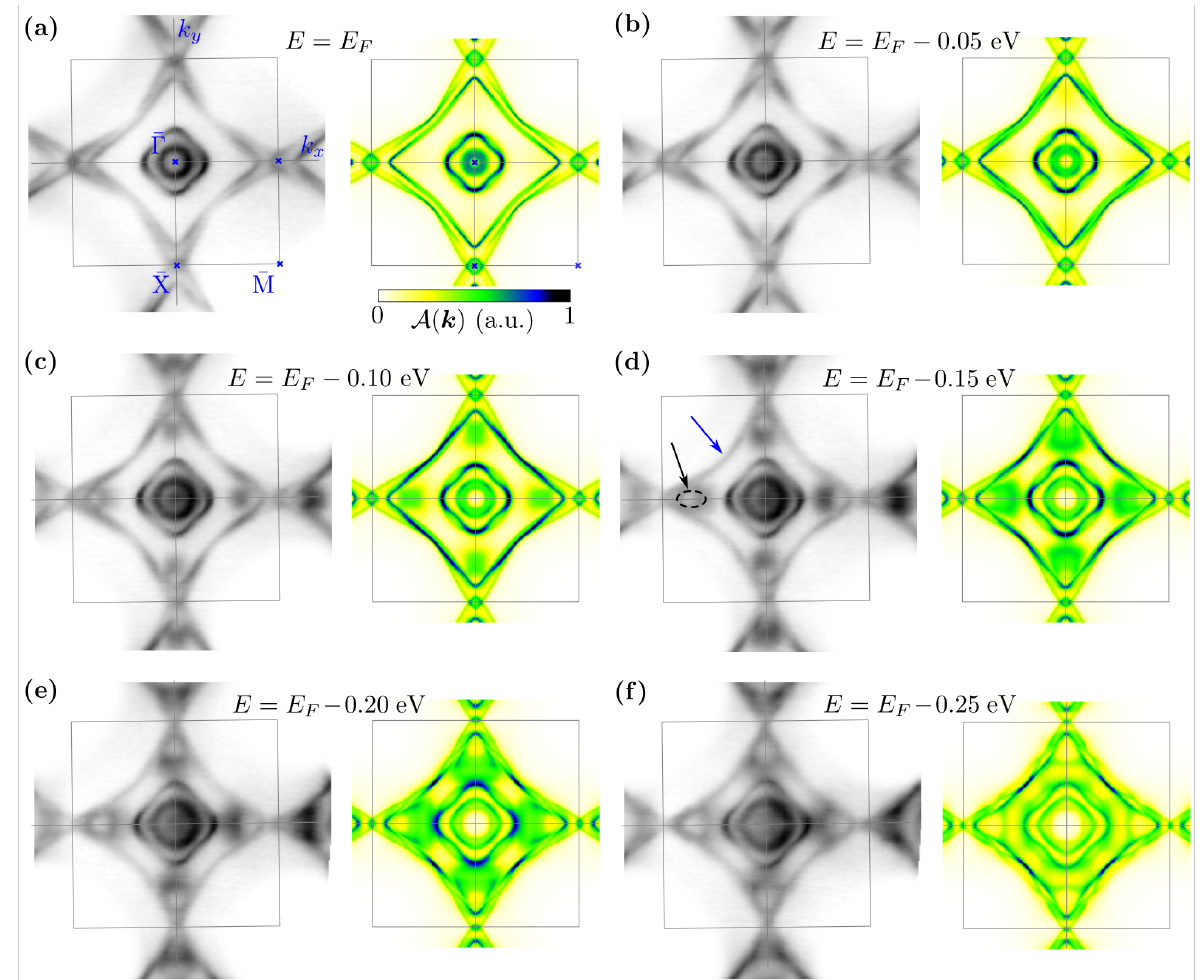
Figure 6. Comparison of the ARPES spectra obtained with a photon energy of 66 eV at a temperature of 12 K ( left panels ) with the theoretical surface spectral function ( right panels ) for selected binding energies E below the Fermi level (as labeled). The gray square denotes the Brillouin zone. The black arrow and the dashed outline indicate the additional branch explained by the spectral